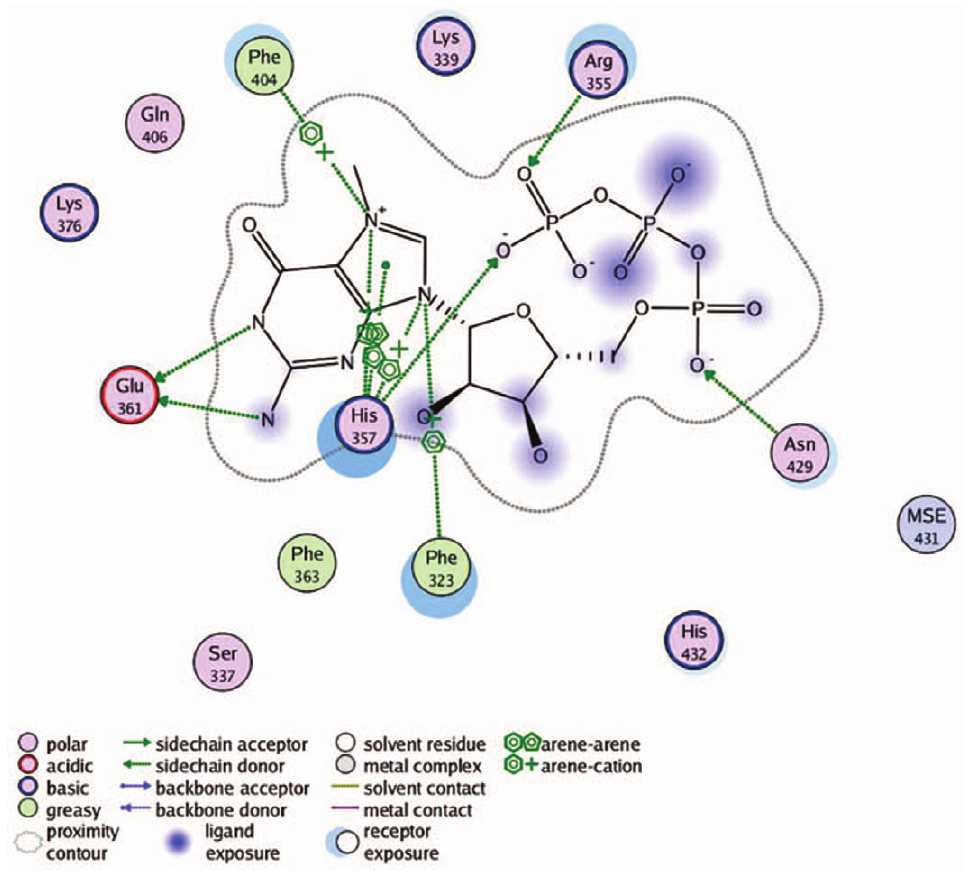
Figure 3. A 2D snapshot from MD simulations to show the binding interactions of the cap analog m7GTP with the key residues in the cap binding domain. The hydrogen bond is shown in green dashed line with the arrow pointed to the hydrogen acceptor. The p - p stacking and p -cation interactions are presented in green benzene ring symbol. The residues without any dashed line or benzene ring symbol have only van der Waals interactions with m7GTP.